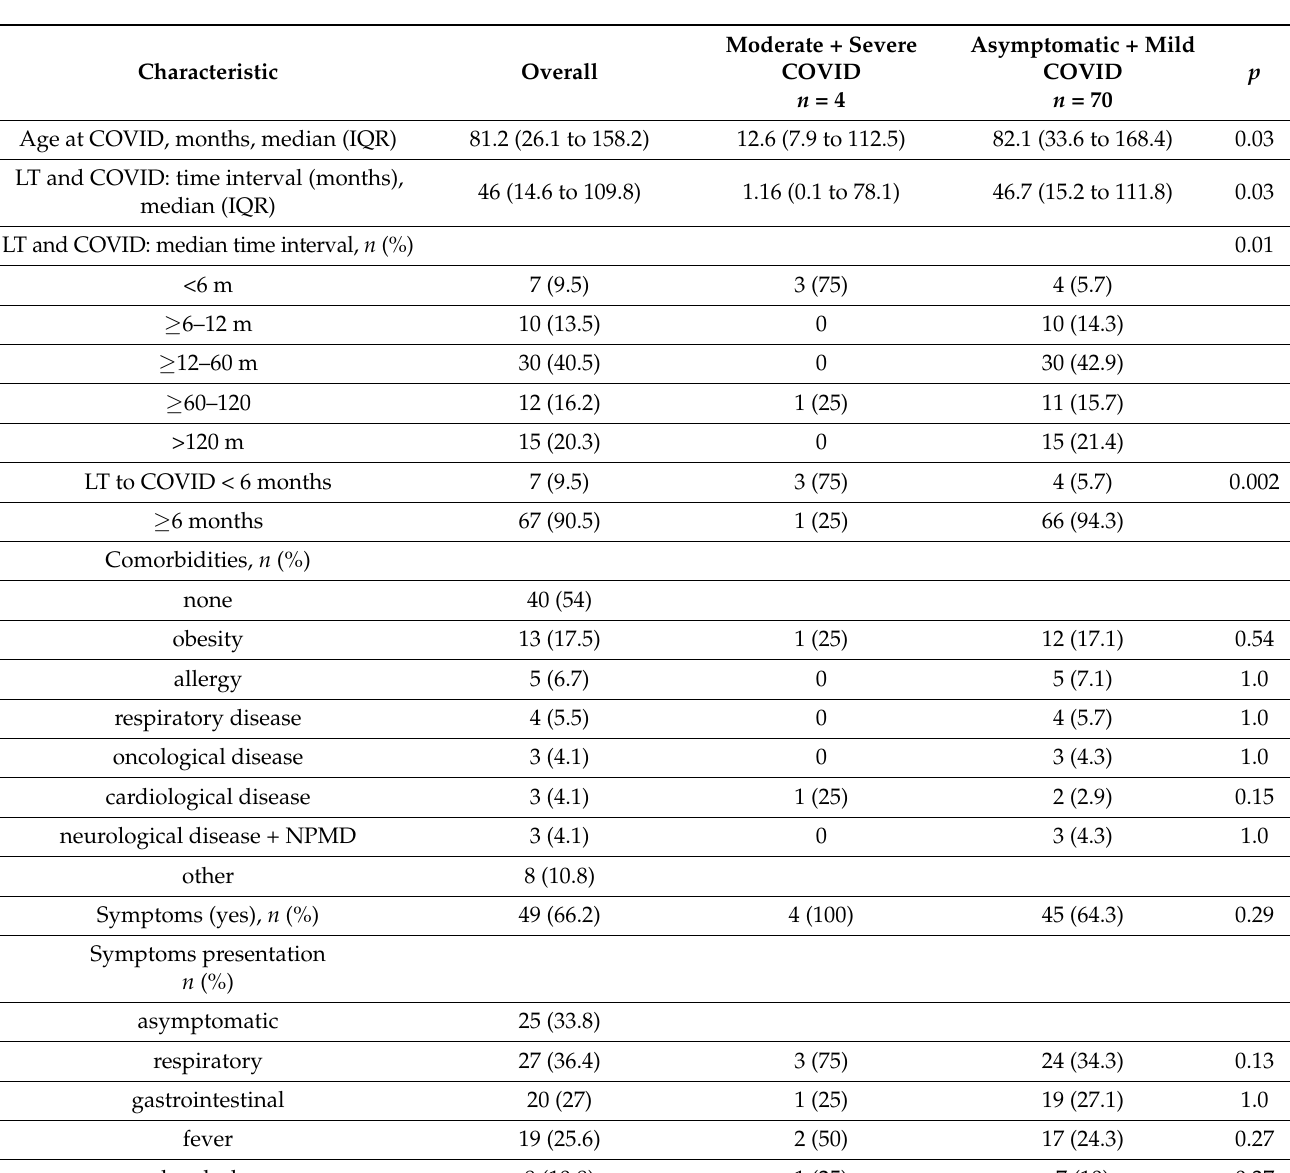
Table 2. Clinical characteristics of severity from 74 PLTR with COVID-19 infection. LT and COVID